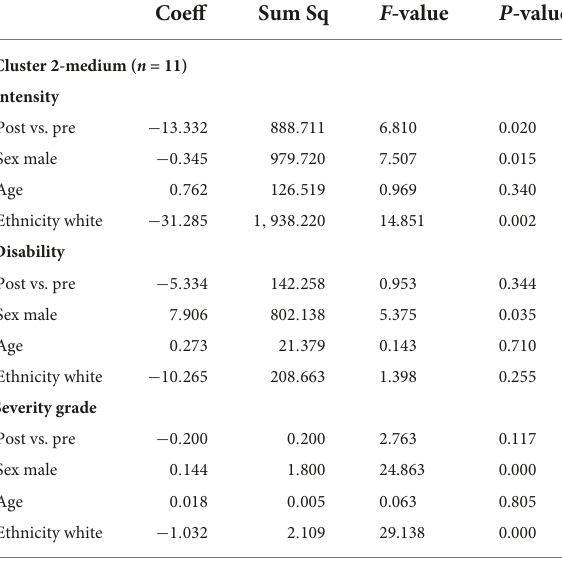
TABLE 8 Multivariable ANOVA, adjusted for demographics (sex male vs. female, age, ethnicity white vs. non-white) for the cluster 2-medium ( n =